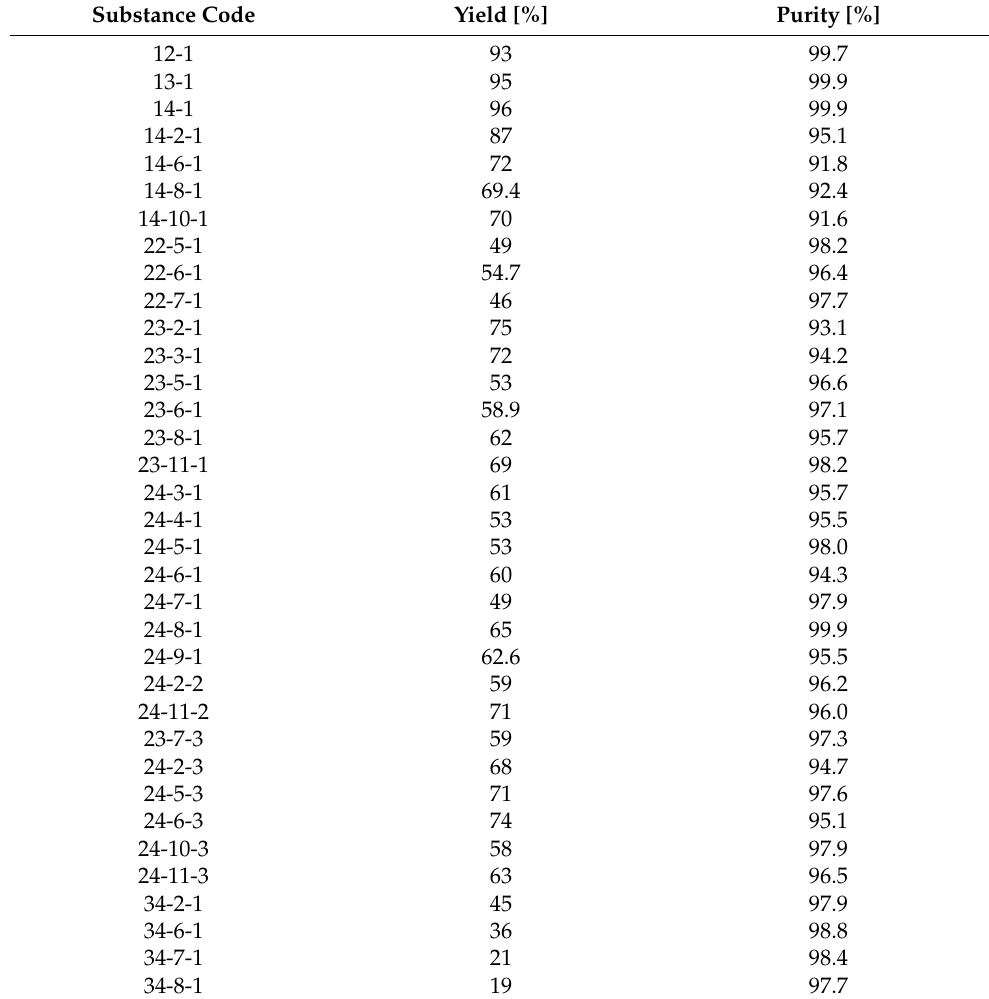
Table 1. Yields and values of purity, determined as chromatography homogeneity by HPLC, of the target compounds and their reaction